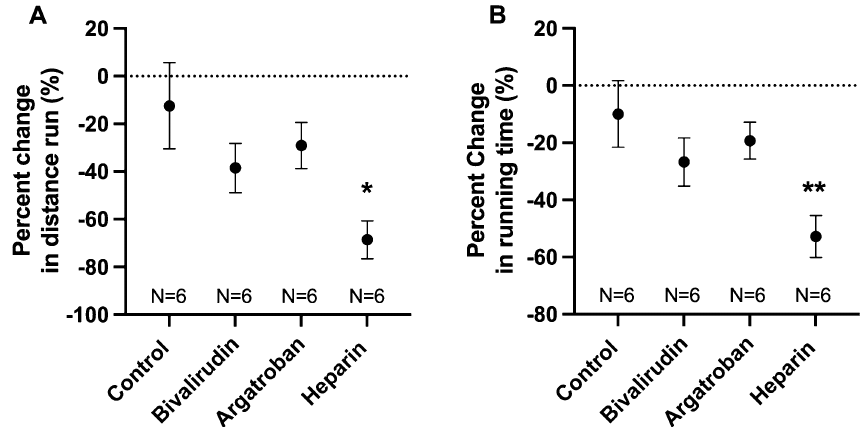
Figure 5. Treadmill exercise tolerance testing (TETT). Mice underwent baseline exercise testing prior to pneumonectomy followed by repeat testing at postoperative day 8. Exercise tolerance was decreased in heparinized mice compared to controls, as measured by the percent change from baseline in distance run ( A ) and time spent running ( B ). There were no significant differences observed in TETT outcomes for the bivalirudin or argatroban groups. Statistical analysis of the experimental groups was done using analysis of variance (ANOVA), with Dunnett’s adjustment for multiple comparisons. Shown are mean ± standard error. *P < 0.05; ** P <